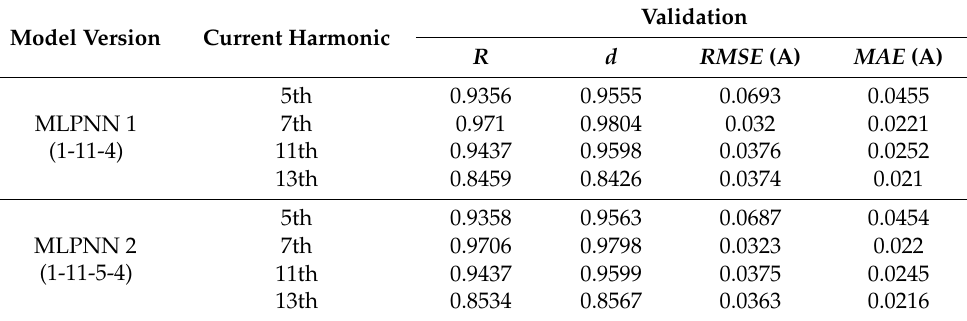
Table 5. Performance of the MLPNN with one input variable ( G ).